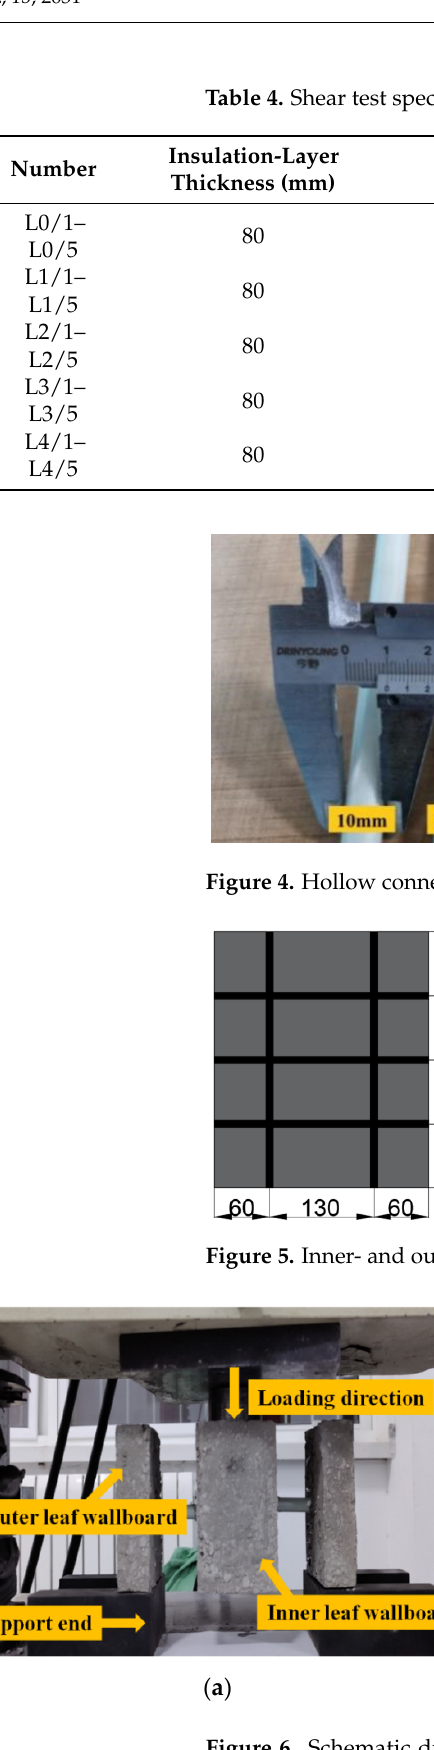
Figure 6. Schematic diagram of shear specimen and loading method (Unit: mm): ( a ) Specimen-loading diagram; ( b ) Specimen size.